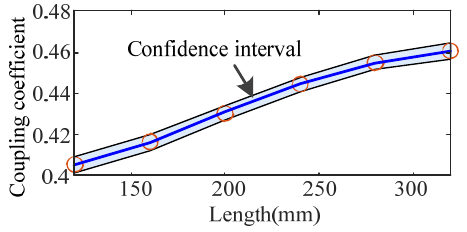
Figure 10. Fitting curve with different lengths.